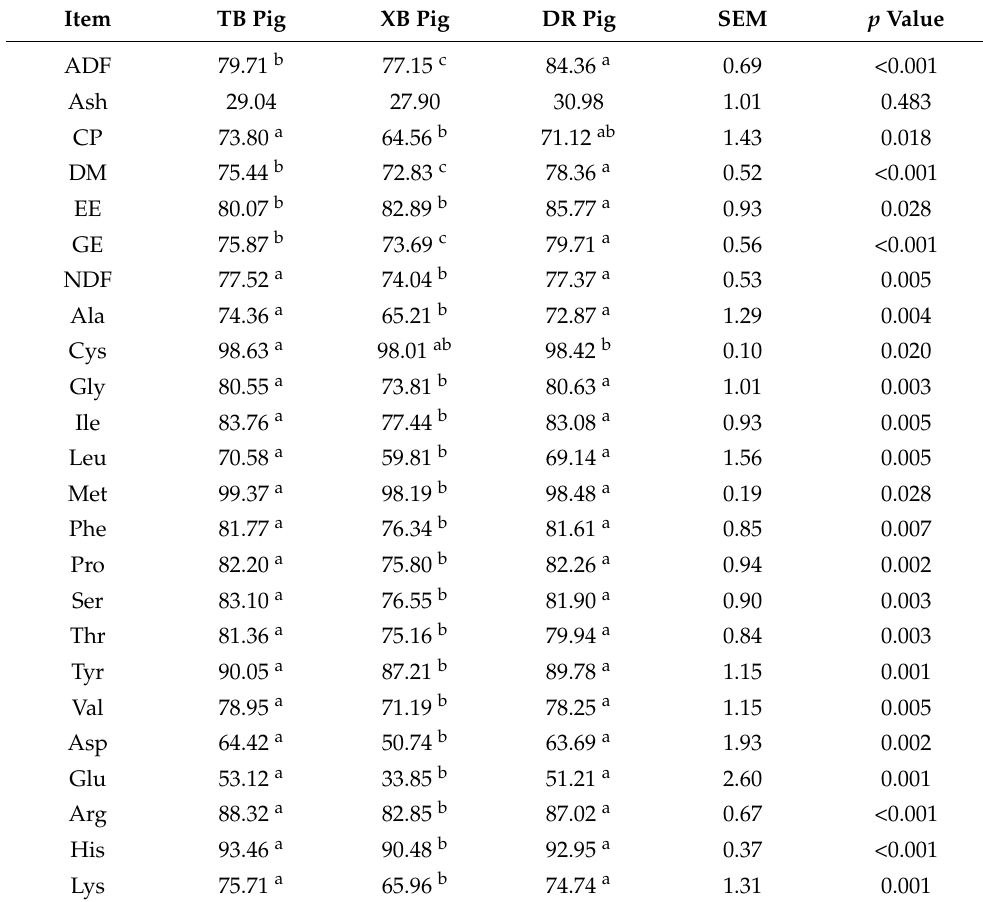
Values in the same row without a common superscript letter are different ( p <